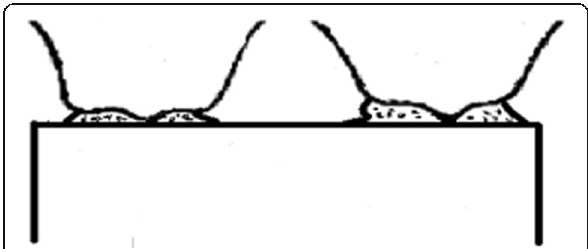
Fig. 2 An illustrative diagram of the surface after applying a liquid composition on the fingerprint